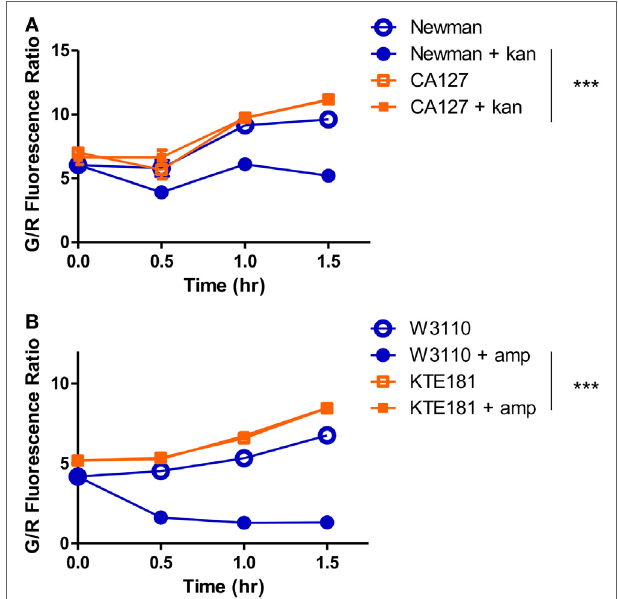
FigUre 2 | SYBR Green I/propidium iodide monitors the dynamics of resistant and sensitive strains during antibiotic drug exposure. A significant decrease in green/red fluorescence ratio was seen as early as 30 min between (a) sensitive Staphylococcus aureus strain Newman and resistant strain CA127 during kanamycin exposure and (B) sensitive Escherichia coli strain W3110 and resistant strain KTE181 during ampicillin exposure (twoway ANOVA, *** p < 0.0005). Data represent the means ±